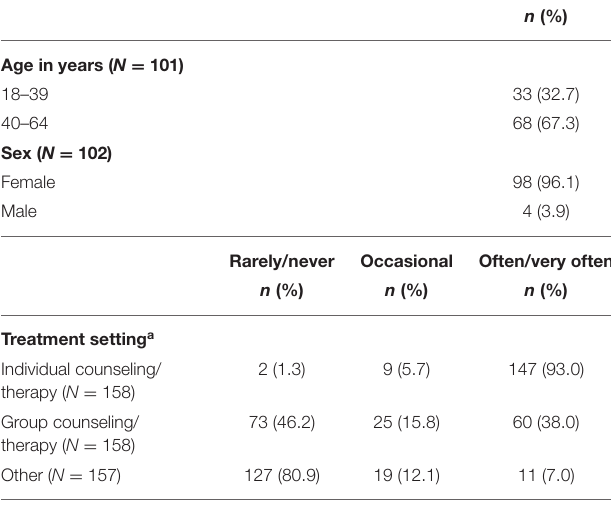
TABLE 1 | Characteristics of the survey population. TABLE 2 | Behavioral and body image therapy approaches for patients with